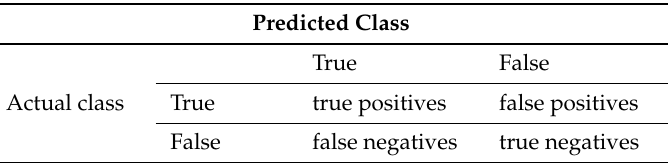
Table 3. Confusion matrix.